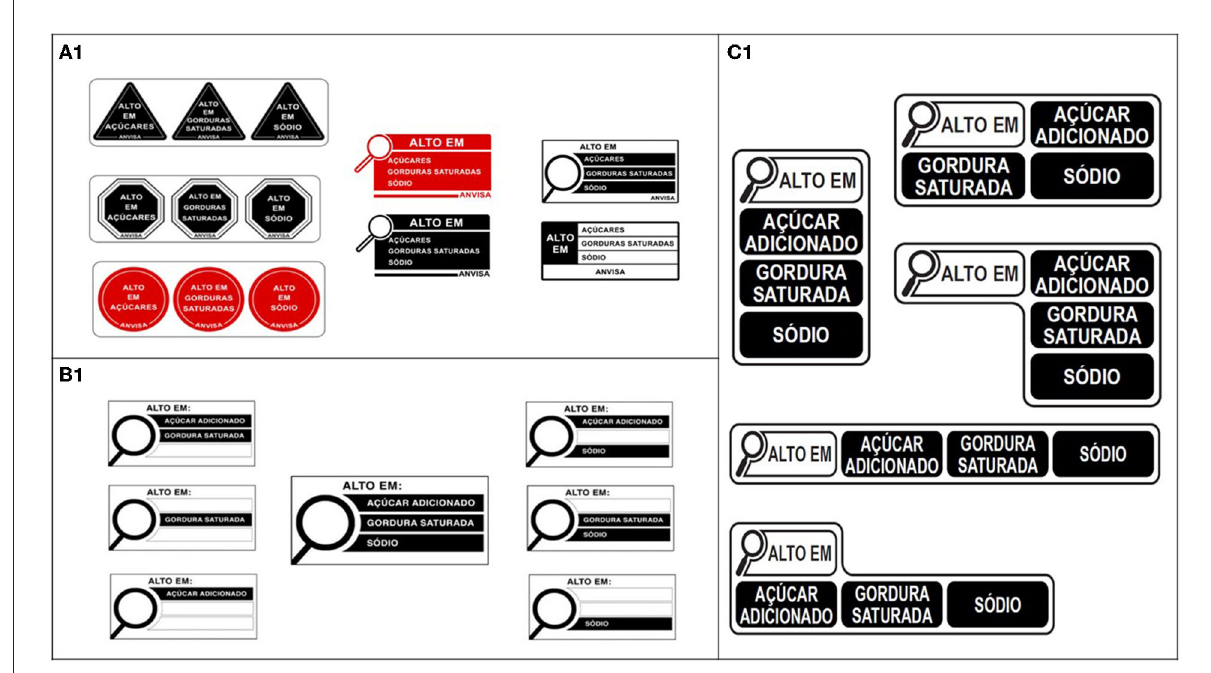
FIGURE1 (A1) Design options of the FoPNL presented by Anvisa in the Preliminary Regulatory Impact Analysis Report on Nutrition Food Labeling in 2018. (B1) Design options of the FoPNL presented by Anvisa in the final public consultation in 2019. (C1) Final design of the FoPNL approved by